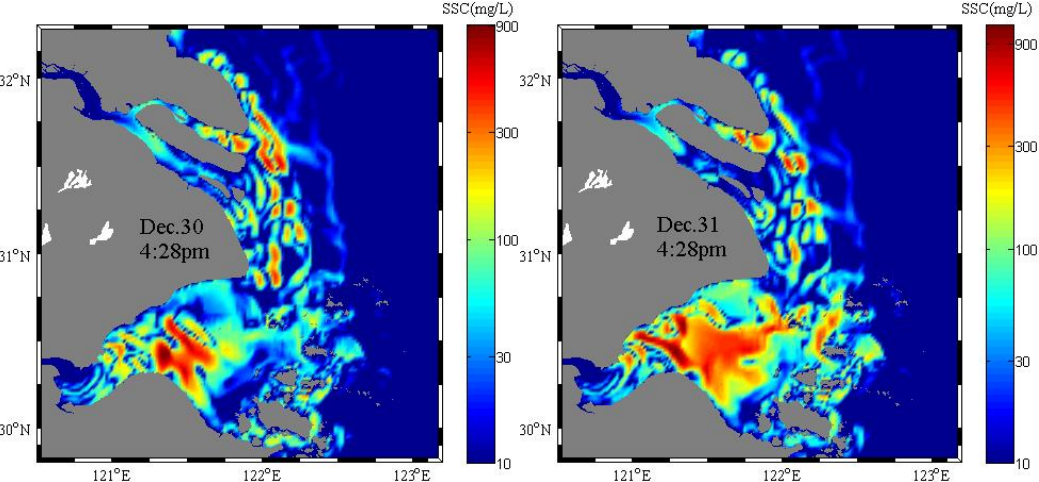
Figure 5. The difference in surface SSC (mg/L) between the GOCI derived and modeled SSC at 4:28 p.m. on 30 and 31 December 2013 for model validation.